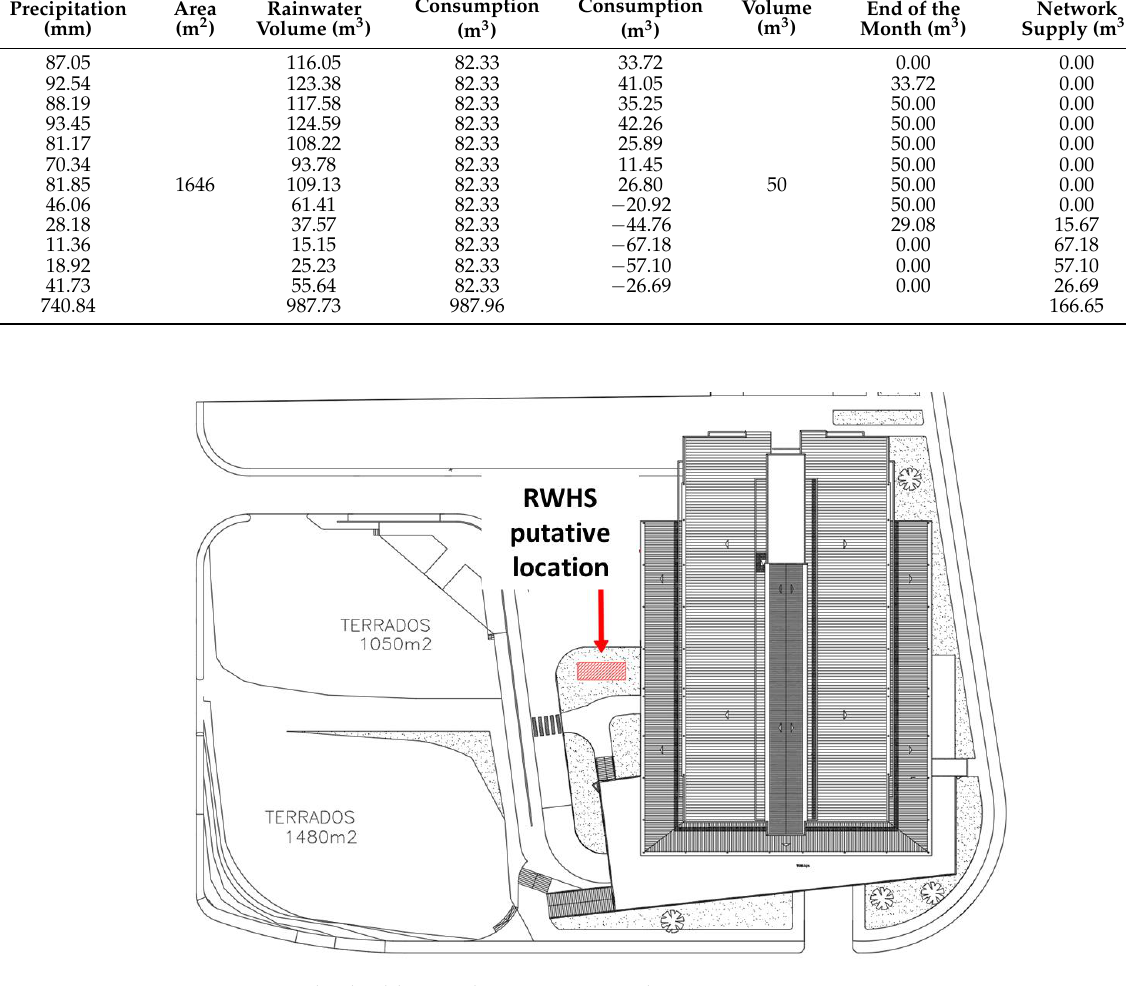
Figure 2. Market building and RWHS putative location.